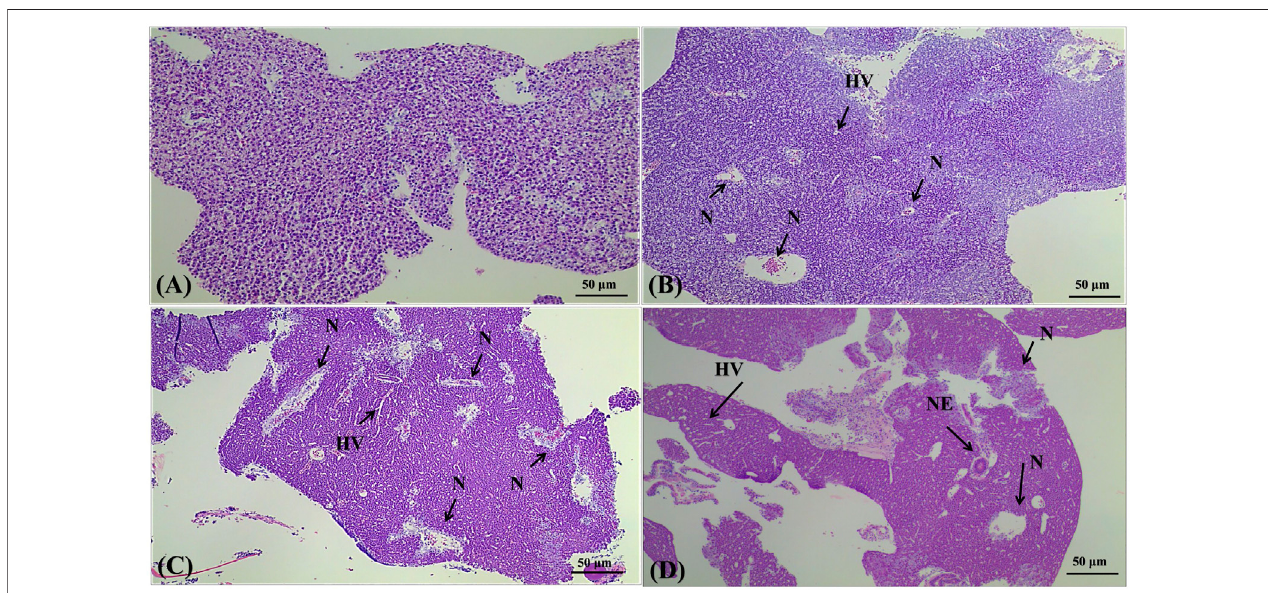
FIGURE 6 | Effects of 4,4 ′ -di-CDE exposure on histology of the liver of zebra fi sh after 14 days of exposure. Light micrographs of sections through the liver of zebra fi sh showing the histological structure of the control group (A) and animals treated with 1 (B) , 10 (C) , and 50 μ g/L (D) 4,4 ′ -di-CDE, respectively. Samples were stained with hematoxylin and eosin, and photomicrographs were taken using ×100 magni fi cation. N, nucleus necrosis; HV, hepatocyte vacuolation; NE, nuclear enlargement.